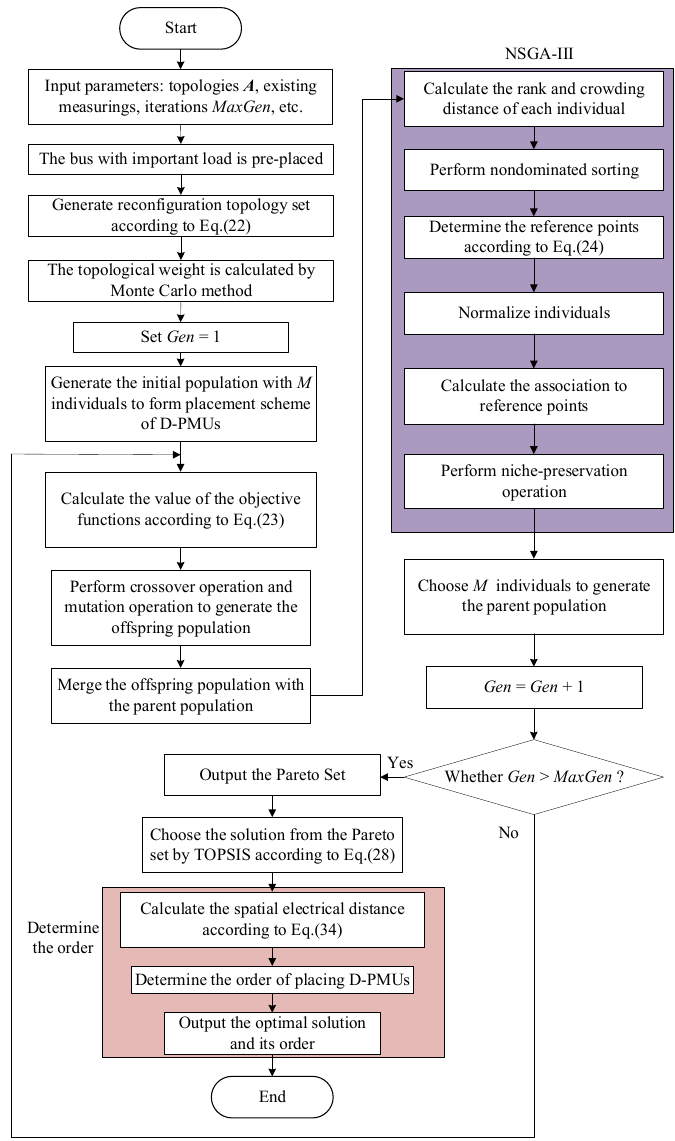
Figure 3. The proposed OPP method flow